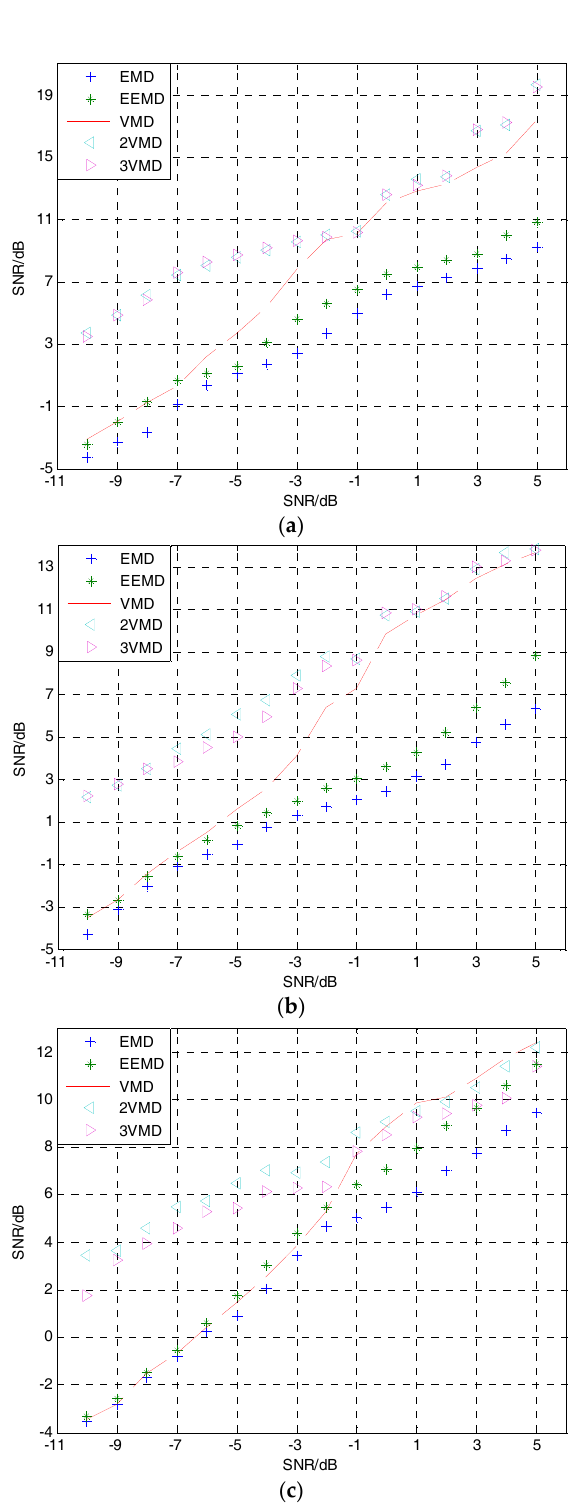
Figure 11. The denoising results of EMD, EEMD, VMD, 2VMD and cubic VMD (3VMD) for different simulation signals. ( a ) The denoising results of simulation 1; ( b ) the denoising results of simulation 2; ( c ) the denoising results of simulation 3.